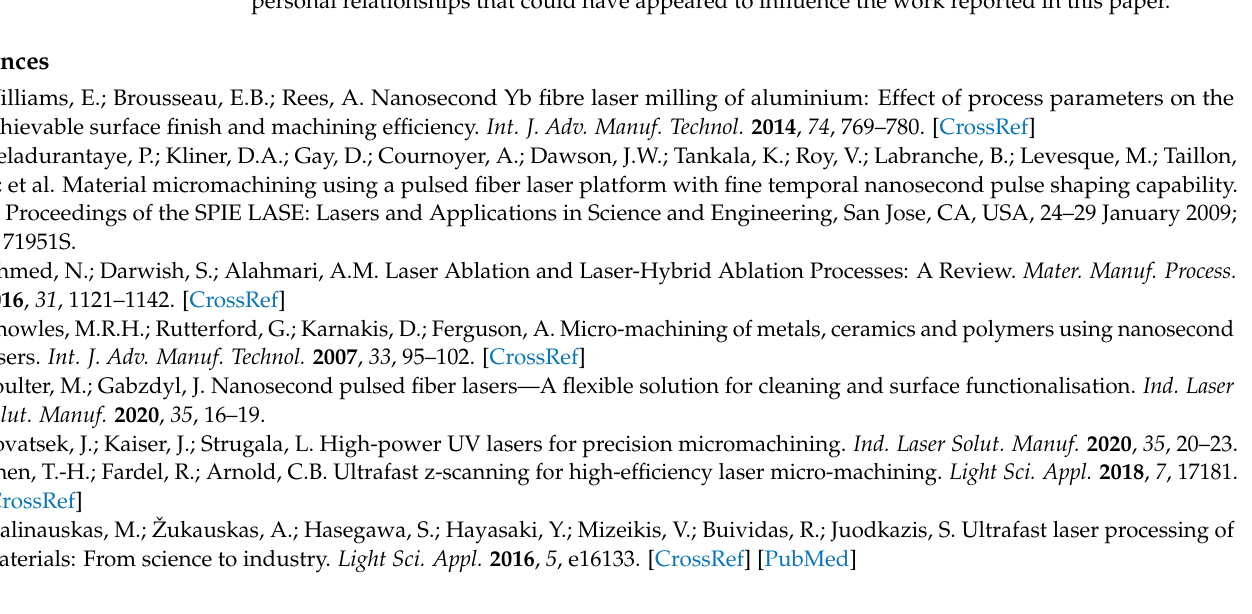
Figure S12: The influence of the laser processing parameters on the surface quality when processing stainless steel AISI 316L; Figure S13: The influence of the ablation depth and processing atmosphere on the surface quality when processing (a) brass CuZn37 and (b) steel AISI 316L in air (the blue points) and argon (the red points) atmospheres; Figure S14: The evolution of (a,c) MRR and (b) surface roughness as a function of pulse-to-pulse and line-to-line overlap when processing brass CuZn37; scanning strategy: 0 ◦ ; (d,e) bottom of ablated areas acquired by an optical microscope using overlaps as they are marked with dots on (c); Figure S15: The evolution of (a,c) MRR and (b) surface roughness as a function of pulse-to-pulse and line-to-line overlap when processing brass CuZn37; scanning strategy: 0 ◦ /45 ◦ /18 ◦ /72 ◦ ; (d) bottom of ablated areas acquired by an optical microscope using overlaps as they are marked with dots on (c); Figure S16: The evolution of (a,c) MRR and (b) surface roughness as a function of pulse-to-pulse and line-to-line overlap when processing steel AISI 316L; scanning strategy: 0 ◦ ; (d,e) bottom of ablated areas acquired by an optical microscope using overlaps as they are marked with dots on (c); Figure S17: The evolution of (a,c) MRR and (b) surface roughness as a function of pulse-to-pulse and line-to-line overlap when processing steel AISI 316L; scanning strategy: 0 ◦ /45 ◦ /18 ◦ /72 ◦ ; (d) bottom of ablated areas acquired by an optical microscope using overlaps as they are marked with dots on (c); Table S1: The main characteristics of the used waveforms: WF is the number of the waveform, E p,max stands for the maximum pulse energy, t FWHM is the pulse duration at the full-width at half maximum, t p,10 is the pulse duration at 10% of the peak power, while P max shows the peak power; Table S2: Laser processing parameters; steel AISI 316L; Table S3: Laser processing parameters; brass CuZn37; Table S4: Laser processing parameters used to determine the influence of scanner parameters on the ablation process; Table S5: Scanner parameters; steel AISI 316L; Table S6: Scanner parameters; brass CuZn37, Supplementary